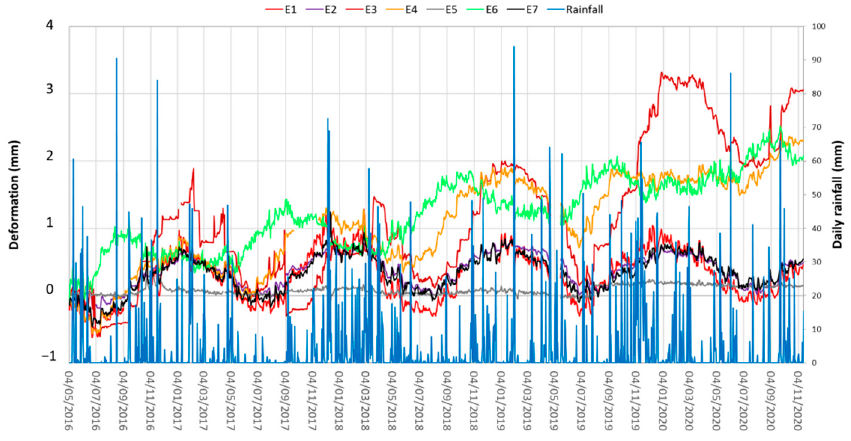
Figure 7. Daily absolute displacement measured by all the sensors of the monitoring system and their comparison with daily rainfall.